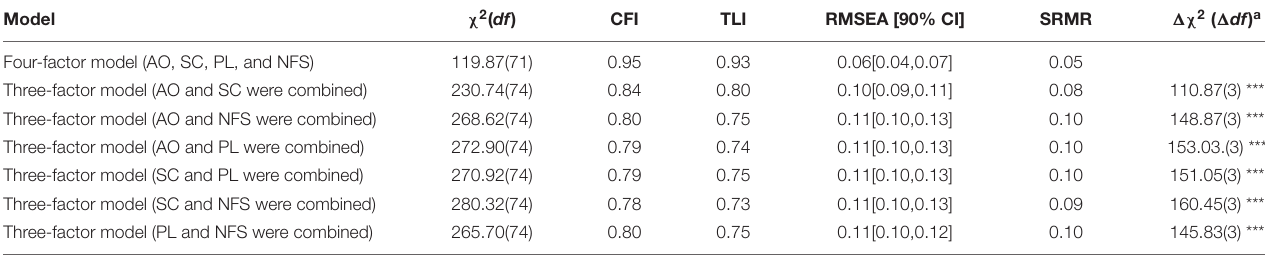
TABLE 1 | Confirmatory factor analysis for discriminant validity. Model